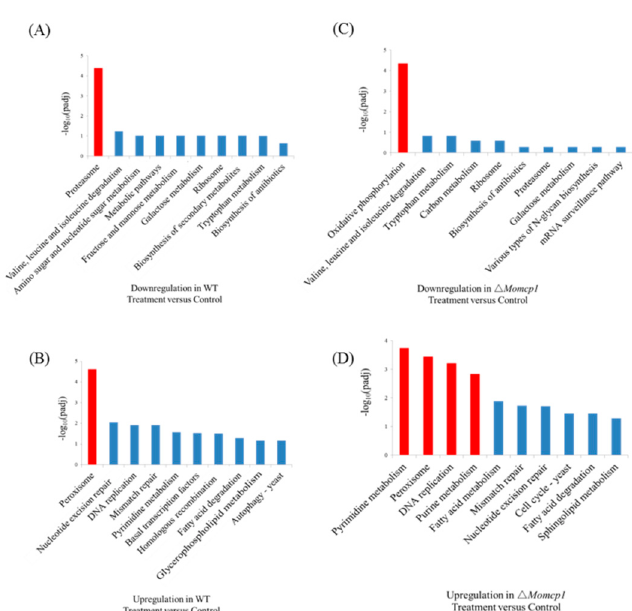
Figure 7. The KEGG pathways in WT and ∆ Momcp1 . ( A ) Down-regulation and ( B ) up-regulation of pathways in WT under 2mM Mn 2+ ; ( C ) Down-regulation and ( D ) up-regulation of pathways in ∆ Momcp1 under 2mM Mn 2+ .